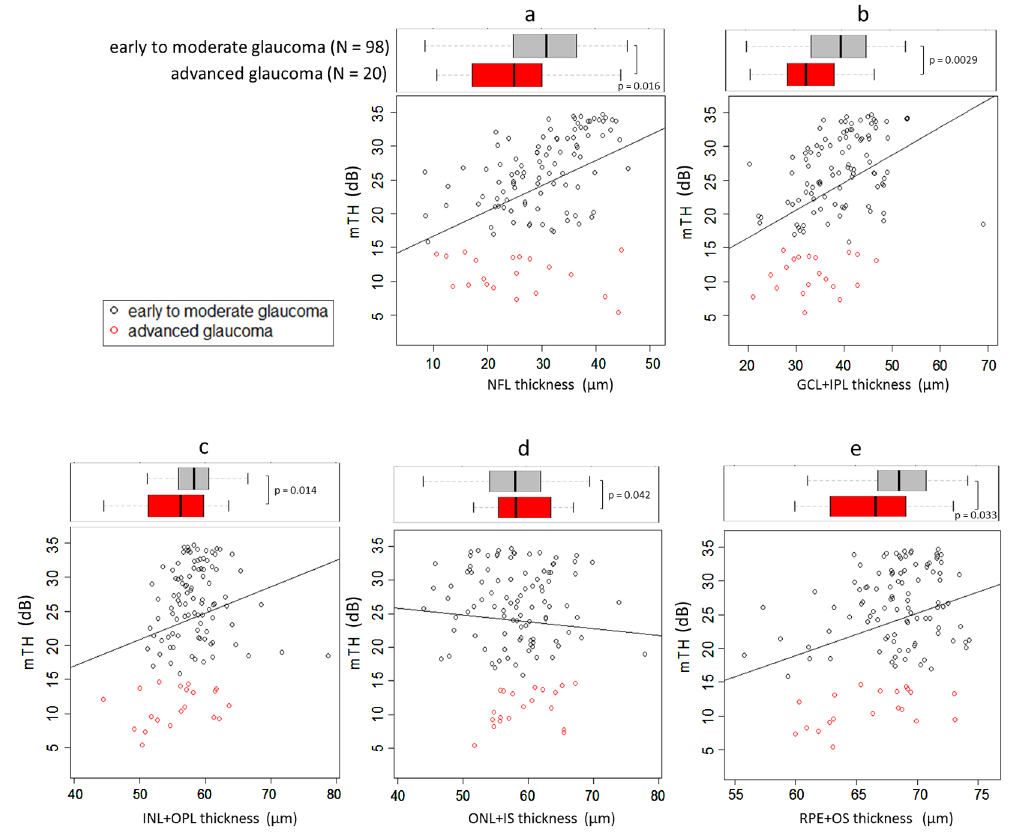
Fig 2. The relationship between retinal layer thickness measurements and mTH. The relationship between retinal layer thickness measurements and mTH was investigated. a: NFL (coefficient = 0.37, p < 0.001), b: GCL+IPL (coefficient = 0.41, p < 0.001), c: INL+OPL (coefficient = 0.39, p = 0.015) and e: OS+RPE (coefficient = 0.63, p < 0.001)were significantly related to mTH however,a significantrelationshipwas not observed betweend: ONL+IS and mTH (coefficient = -0.10, p = 0.41). mTH: mean threshold, NFL: nerve fiber layer, GCL+IPL: ganglioncell and inner plexiformlayer, INL+OPL: inner nuclear layer and outer plexiform layer, ONL+IS: outer nuclear layer and inner segment layer: OS+RPE outer segment layer and retinal pigment